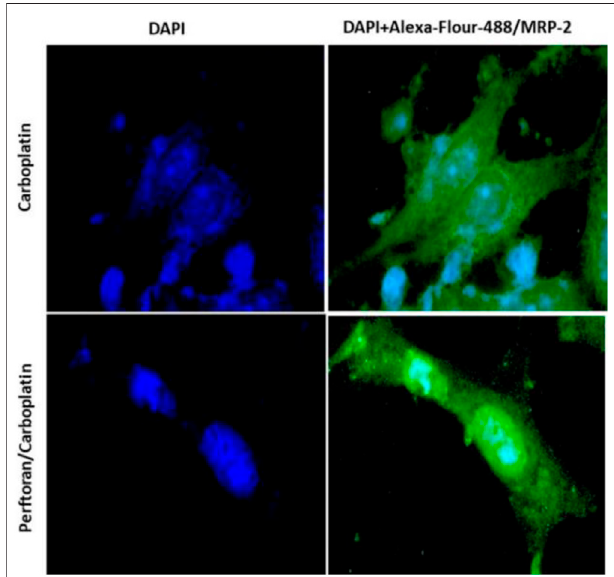
FIGURE 4 | Immunocytochemical analysis of MRP-2: A549 cells were immunocytochemically stained with Alexa- fl our-488-conjugated IgG and MRP-2 antibody (green), while nuclei were counterstained with DAPI (blue). Cellstreatedwithcarboplatin showedhighMRP-2concentrations,while cells treated with both Perftoran ® and carboplatin exhibited lower MRP-2 concentrations. The cells were analyzed under a fl uorescence microscope (200 × magni fi